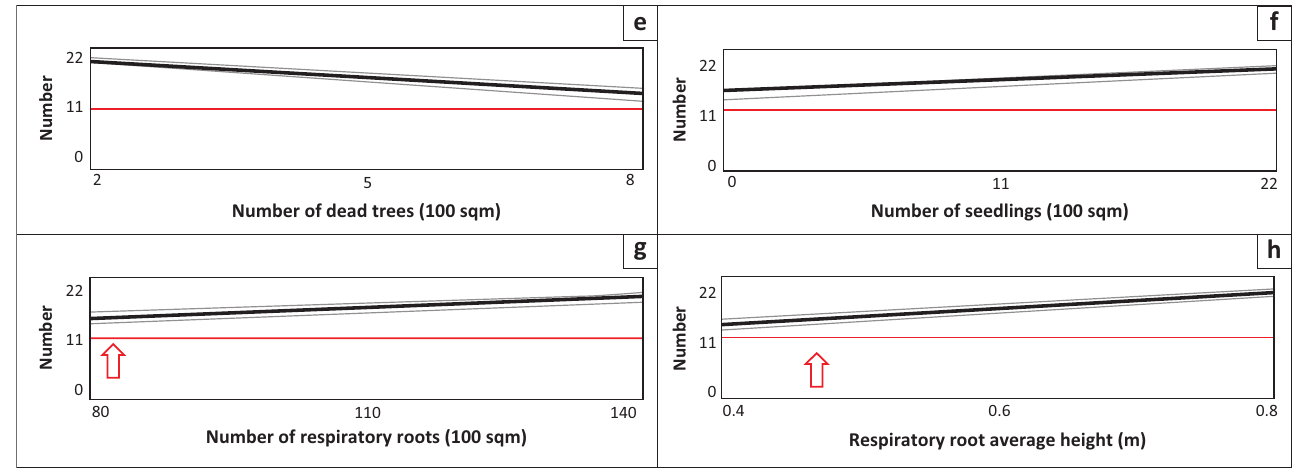
Red arrows = a higher precision of uncertainty. FIGURE 5 (Continues...): Al Mudhaylif demographic features sensitivity analysis: (a) Density (100 m 2 ); (b) Cover ( % ); (c) Tree height (m); (d) Crown diameter (m); (e) Number of dead trees (100 m 2 ); (f) Number of seedlings (100 m 2 ); (g) Number of respiratory roots (100 m 2 ) and (h) Average height of respiratory roots (m).